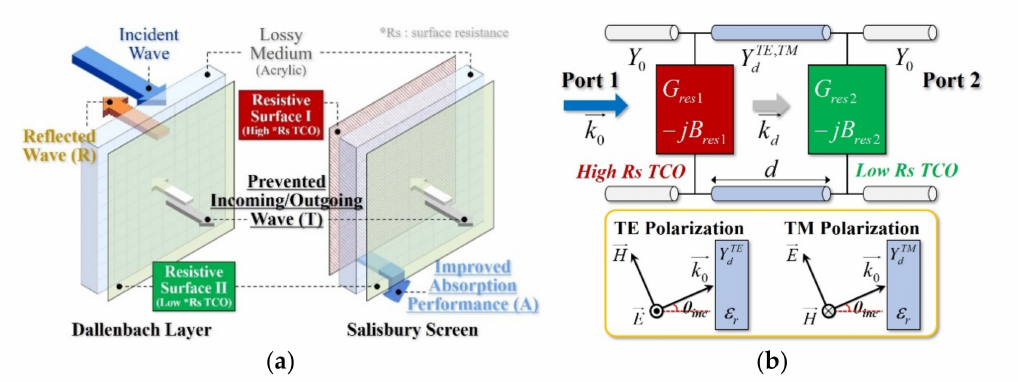
Figure 2. The configuration of the optical transparent absorber and equivalent circuit model: ( a ) structure of a transparent conductive oxide (TCO) coated acrylic absorber and an ( b ) equivalent circuit